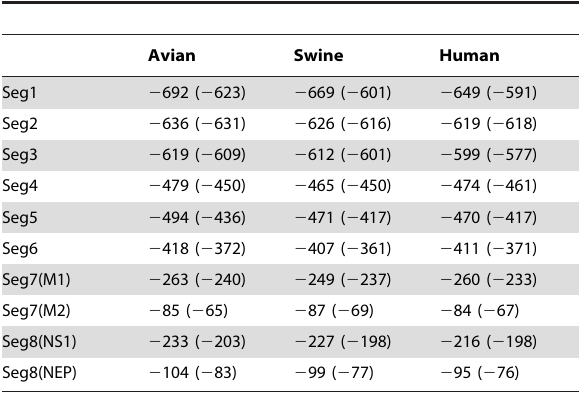
Table 2. Average predicted free energies (kcal/mol) at 37 u C for ( + ) and ( 2 )RNA*.